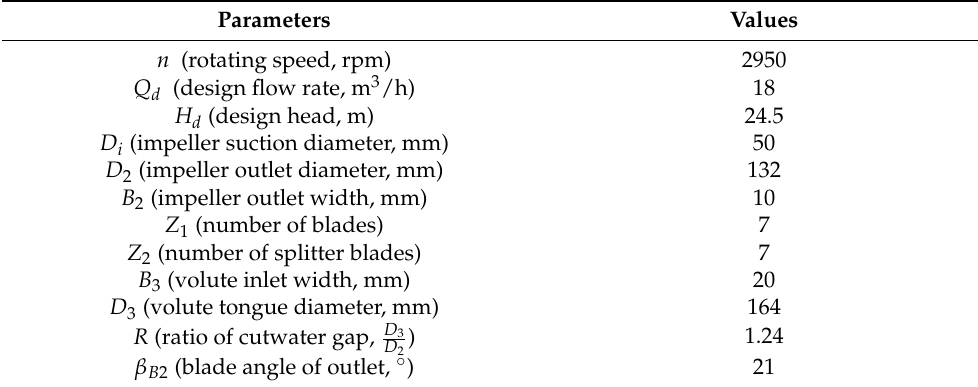
Table 1. Factors and their levels.